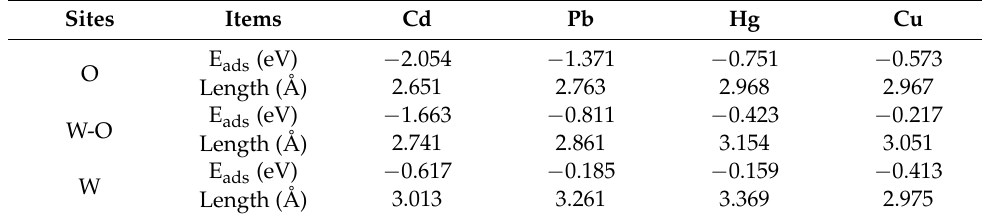
Table 3. Adsorption energy of different heavy metal ions on the WO 3 -modified electrode surface.